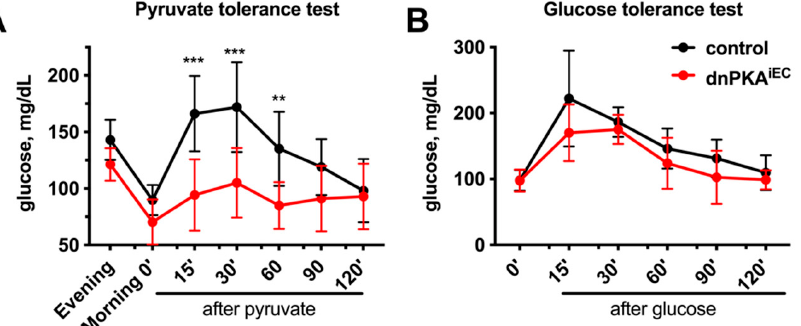
Figure 7. Inhibition of endothelial PKA impairs gluconeogenesis. ( A ), dnPKA iEC mice were unable to respond to a bolus i.p. injection of pyruvate by increasing blood glucose levels. Here, 10 control (Tg(Cdh5-cre/ERT2)1Rha without floxed transgenes) and 15 dnPKA iEC mice were analyzed. Shown are means ± SD. ( B ), dnPKA iEC mice preserved the ability to regulate blood glucose levels after a bolus i.p. injection of glucose. 5 control (Tg(Cdh5-cre/ERT2)1Rha without floxed transgenes) and 6 dnPKA iEC mice were analyzed. Shown are means ± SD. Mice were injected with tamoxifen at the age of 28–32 days. Pyruvate and glucose tolerance tests were performed 30–40 days after tamoxifen injection (at the age between 60 and 70 days). Data were analyzed using two-way ANOVA followed by Sidak’s multiple comparison test. **, p < 0.01; ***, p < 0.001.